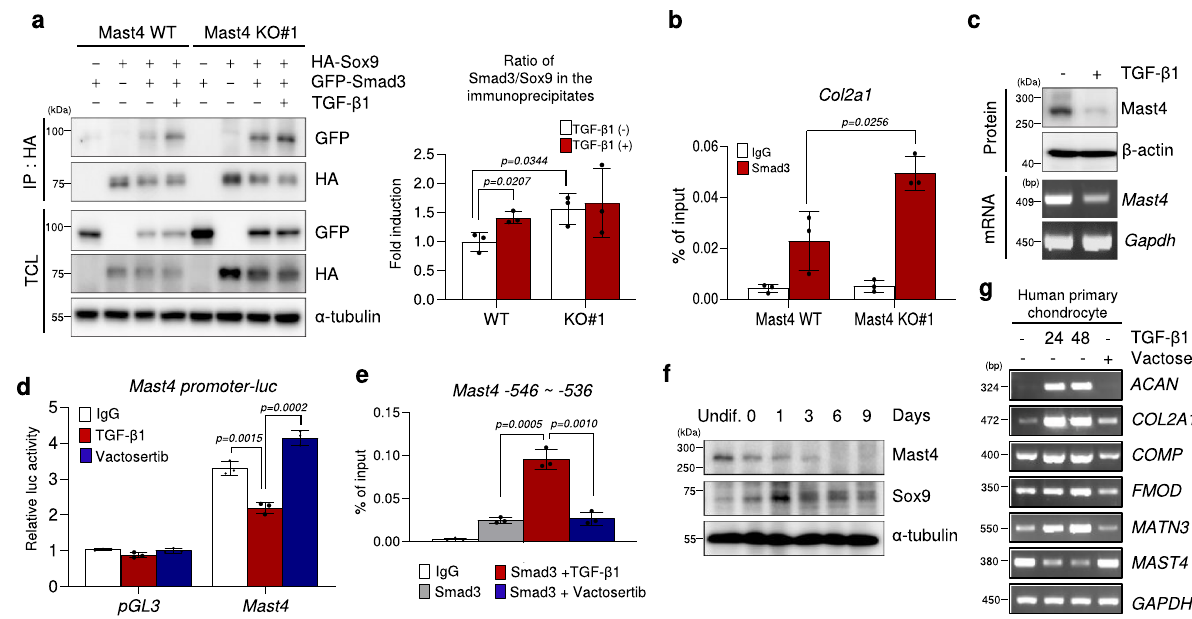
Fig. 3 TGF- β 1-induced suppression of Mast4 enhances chondrogenesis by increasing Sox9-Smad3 association. a Sox9 and Smad3 were